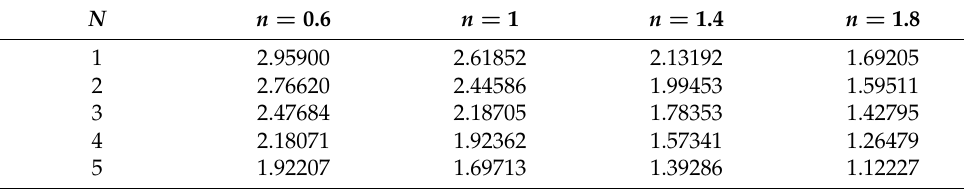
Table 9. The values of the average Nusselt number ( Nu avg ) at the solid-fluid interface.